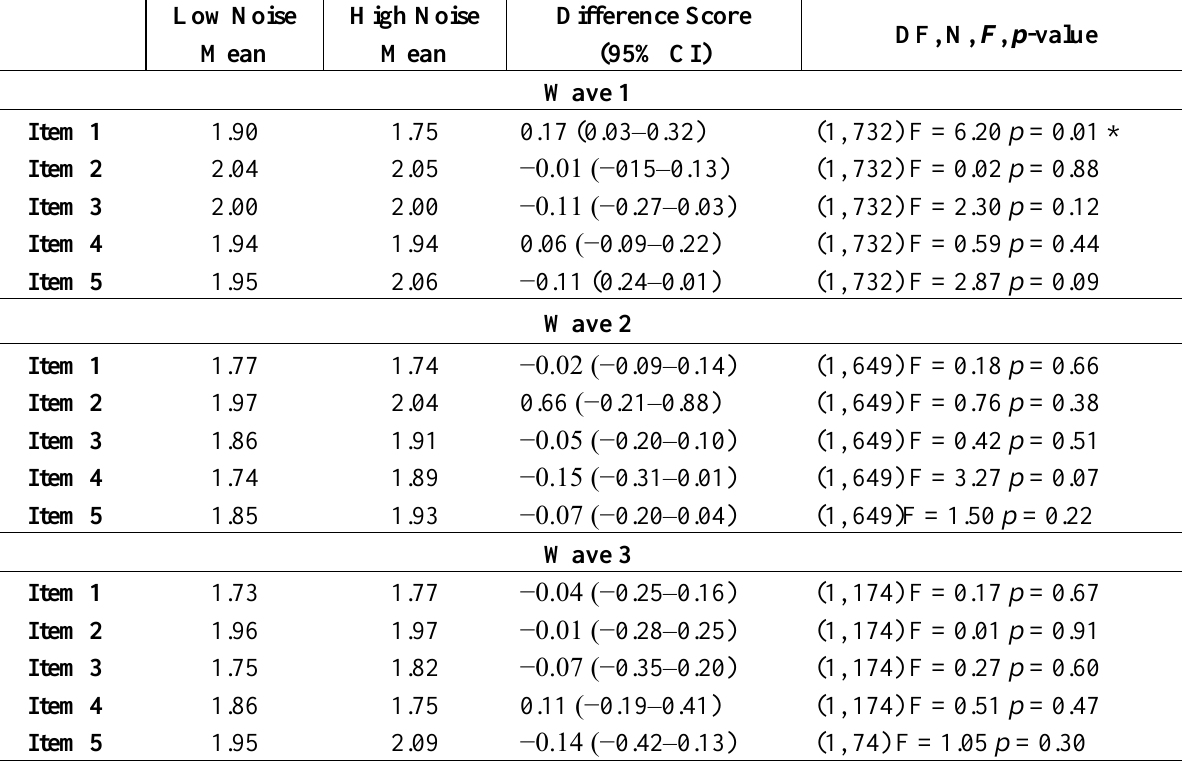
Table 3. Child Self-Reported